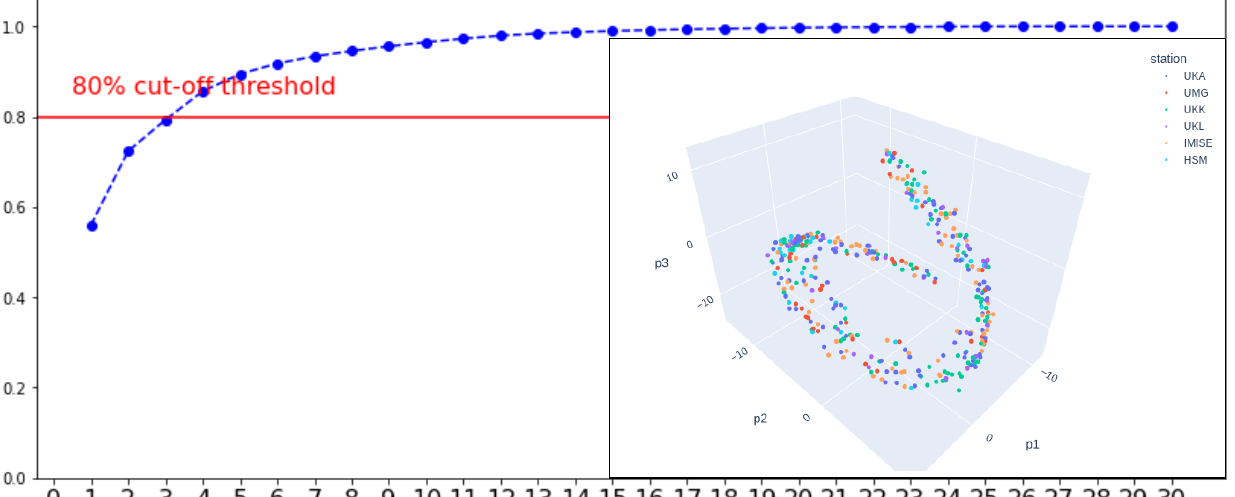
Figure 5. Cumulative variance ( y axis) of the sorted PCs ( x axis). This plot demonstrates that the first three PCs are sufficient to describe 80% of the data variance-in other words: By keeping three components, there is only an information loss of 20%. The bottom right t-SNE plot shows the feature distribution of the first three PCs amongst each participating institution: UKA, UKK, UKL, UMG, HSM,